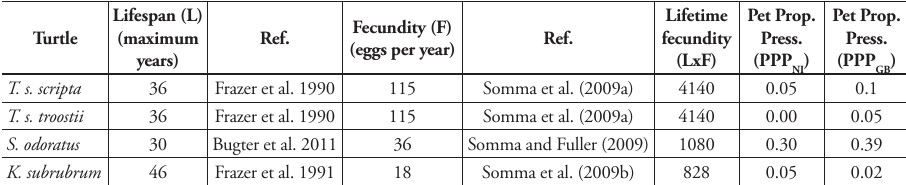
Table 1. Numerical response proxies of lifespan, fecundity and lifetime fecundity, plus Pet Propagule Pressure (PPP; see Text and Table 3) for our study turtle species. Pet Propagule Pressure (Northern Ireland, NI) is a function of the proportional availability of each species across pet shops and the total number of pet shops surveyed and PPP (Great Britain, GB) is the proportional availability of the four species based on online classified advertisements and the total number of online advertisements